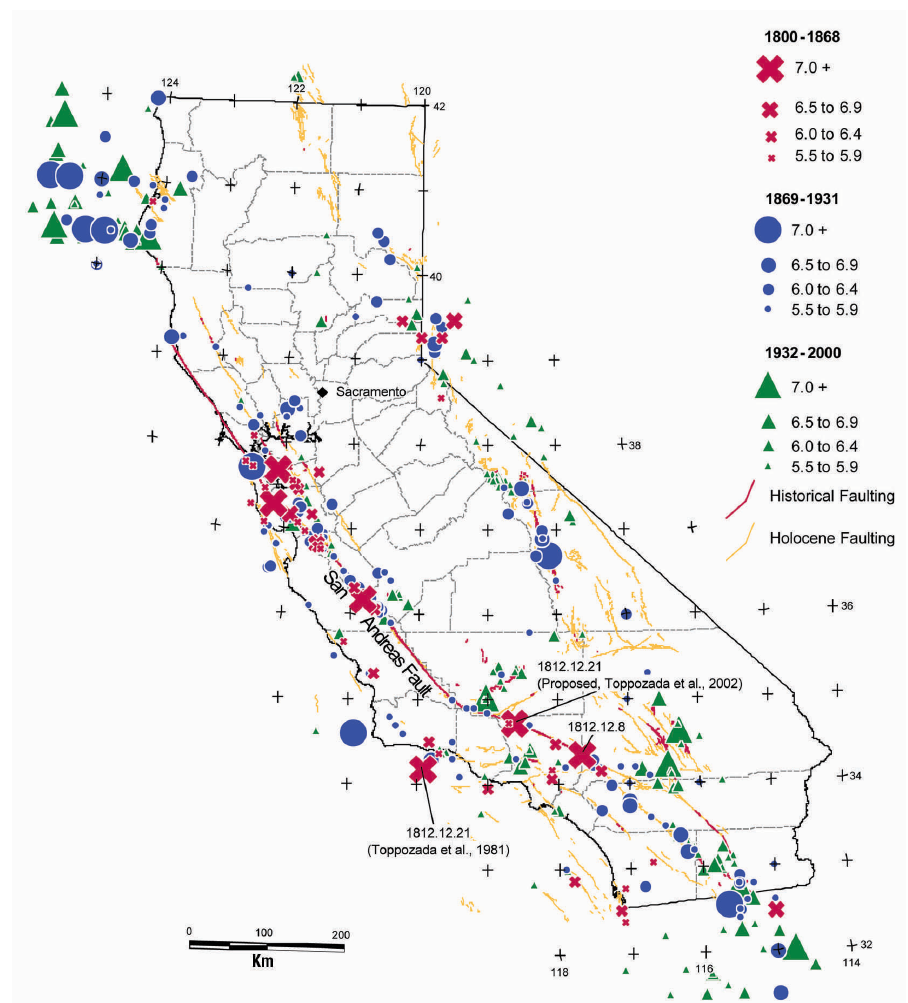
Fig. 3. Magnitude greater or equal to 5.5 California earthquakes, 1800-2000 (modified from Toppozada and Branum,